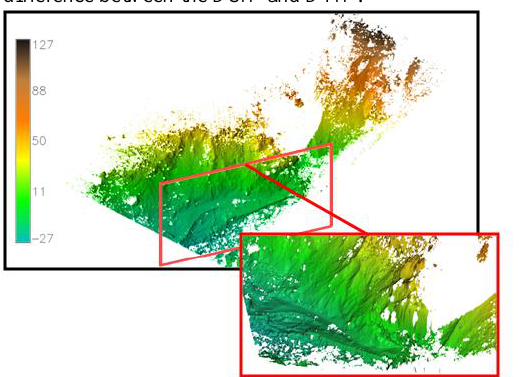
Figure 7. The digital terrain model at 0.1 m resolution (meters).